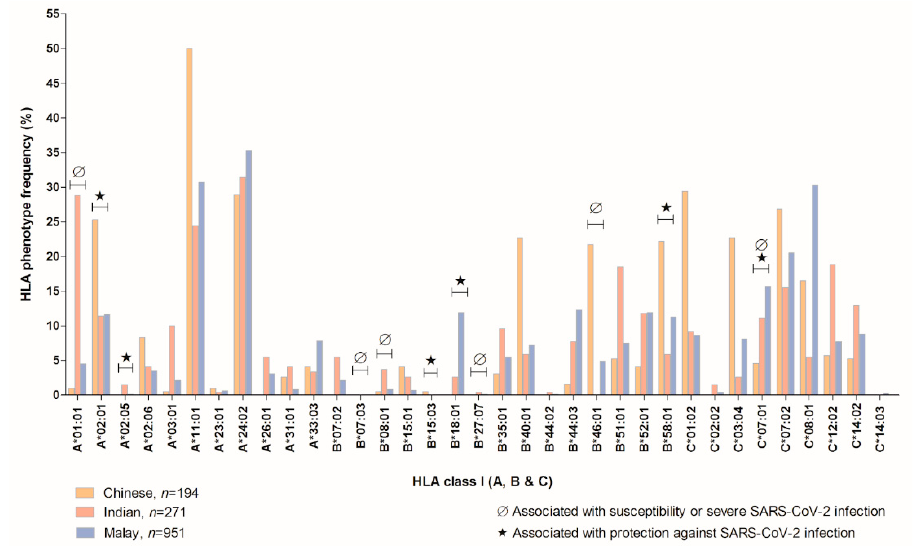
Figure 2. HLA class I phenotype frequency in Malaysia Peninsular Chinese, Indian, and Malay populations extracted from allelefrequencies.net in corresponding to SARS-CoV-2 epitopes recognition. The HLA phenotypes were collected from reported bioinformatics, case-control, and cohort